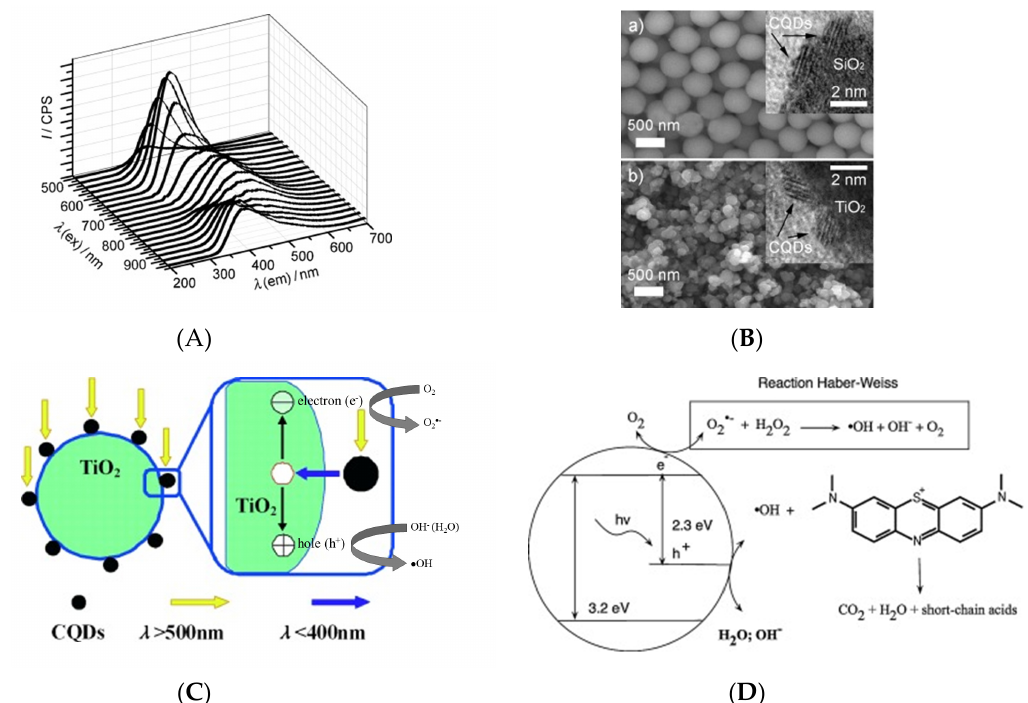
Figure 6. ( A ) Upconversion property on photoluminescence of CDs. ( B ) Scanning electron microscope (SEM) image of SiO 2 / CDs and TiO 2 / CDs photocatalysts; Insertion shows the confirming HR-TEM images. ( C ) Photocatalytic mechanism of TiO 2 / CDs nanocomposite in the range of visible and UV light; Reproduced with permission from [32]. Copyright © 2010 WILEY-VCH Verlag GmbH & Co. KGaA, Weinheim. ( D ) Photocatalytic mineralization of methylene blue; Reproduced with permission from [57] published by Elsevier,